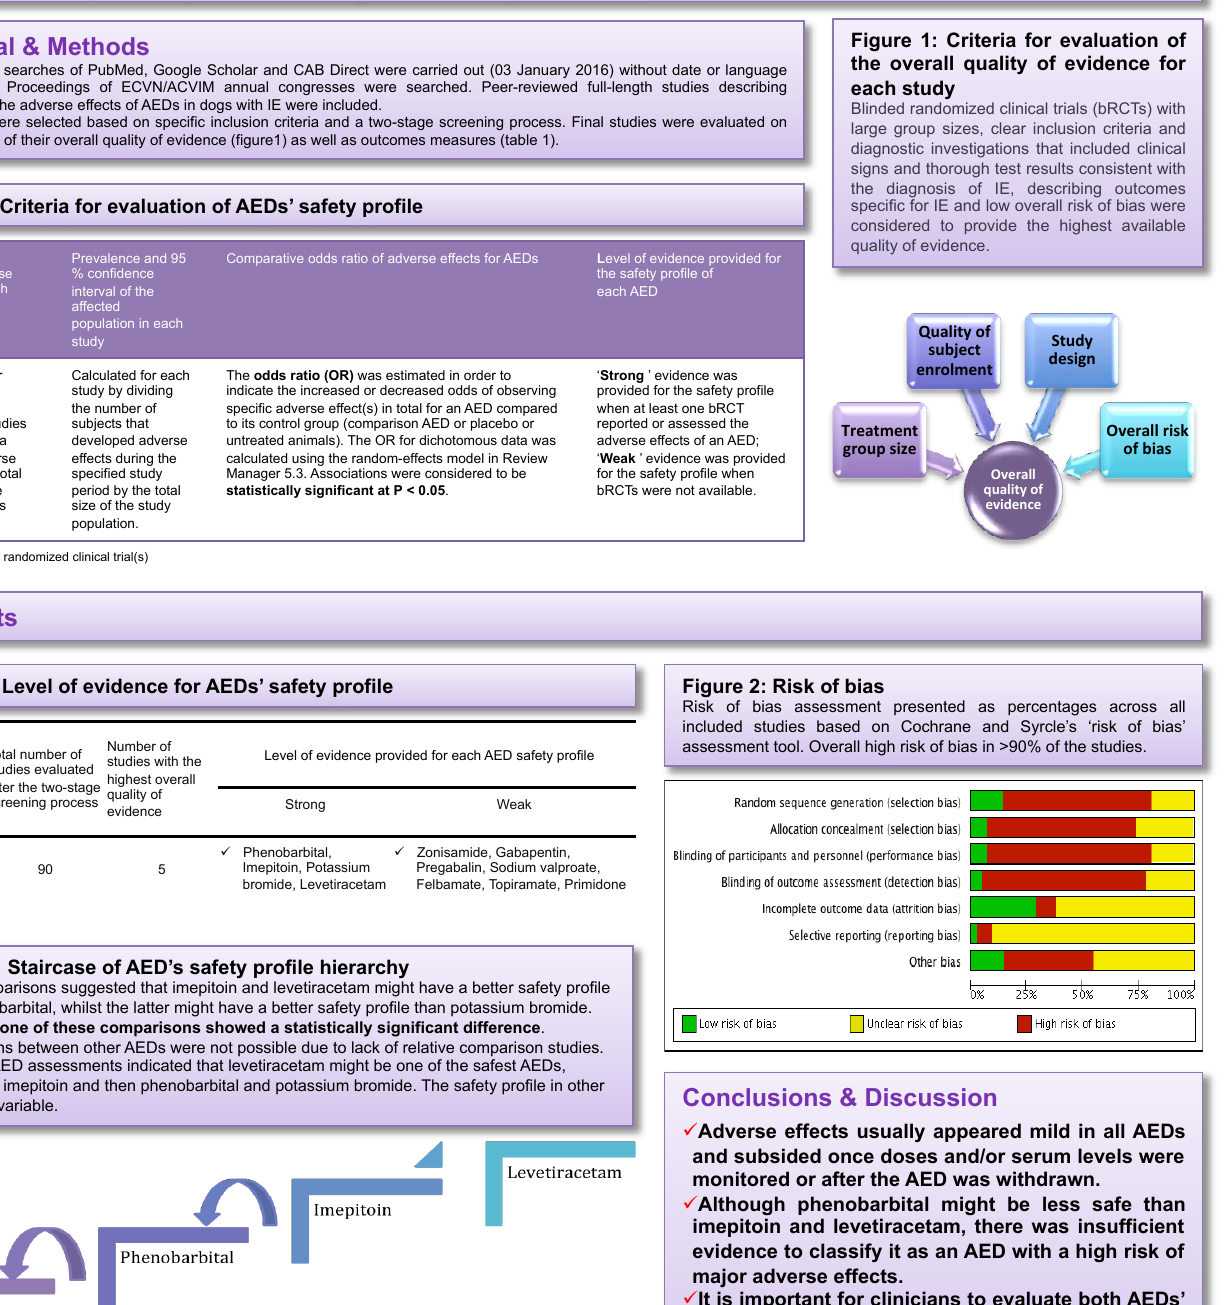
Table 1: Criteria for evaluation of AEDs’ safety profile